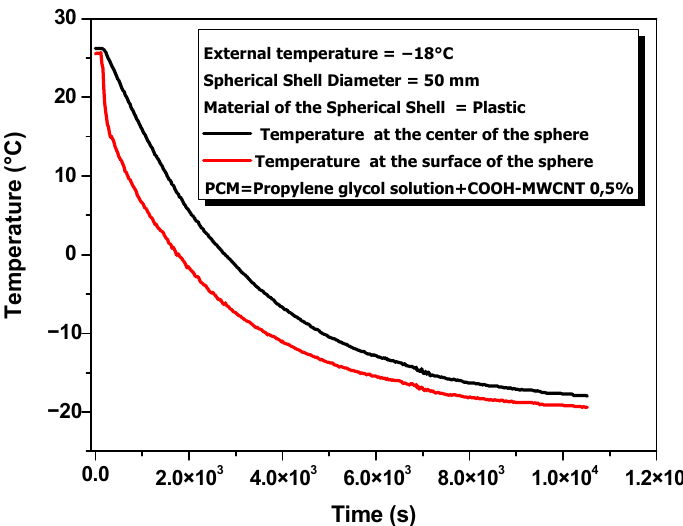
Figure 11. Temperature change in the center of the plastic spherical capsule during solidification of